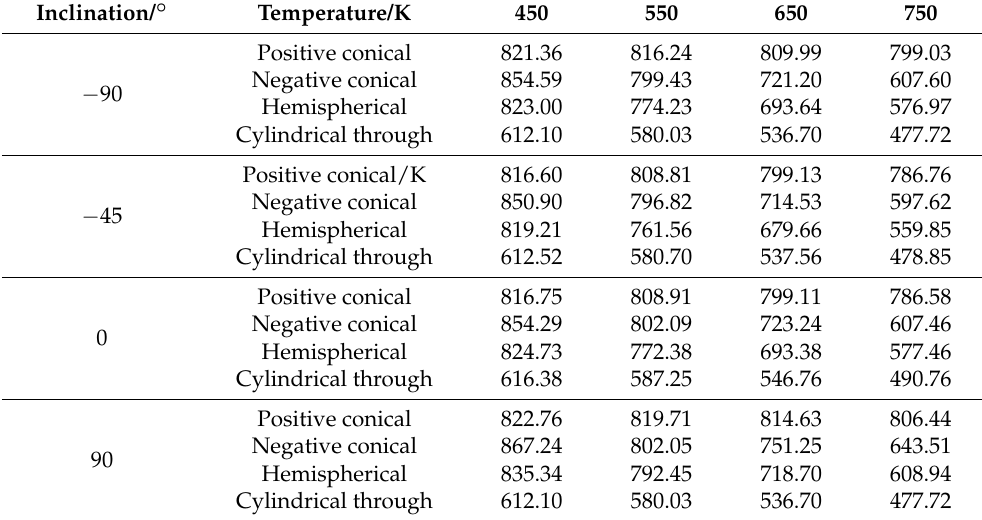
Table 6. Thermal conversion in cavities/W.